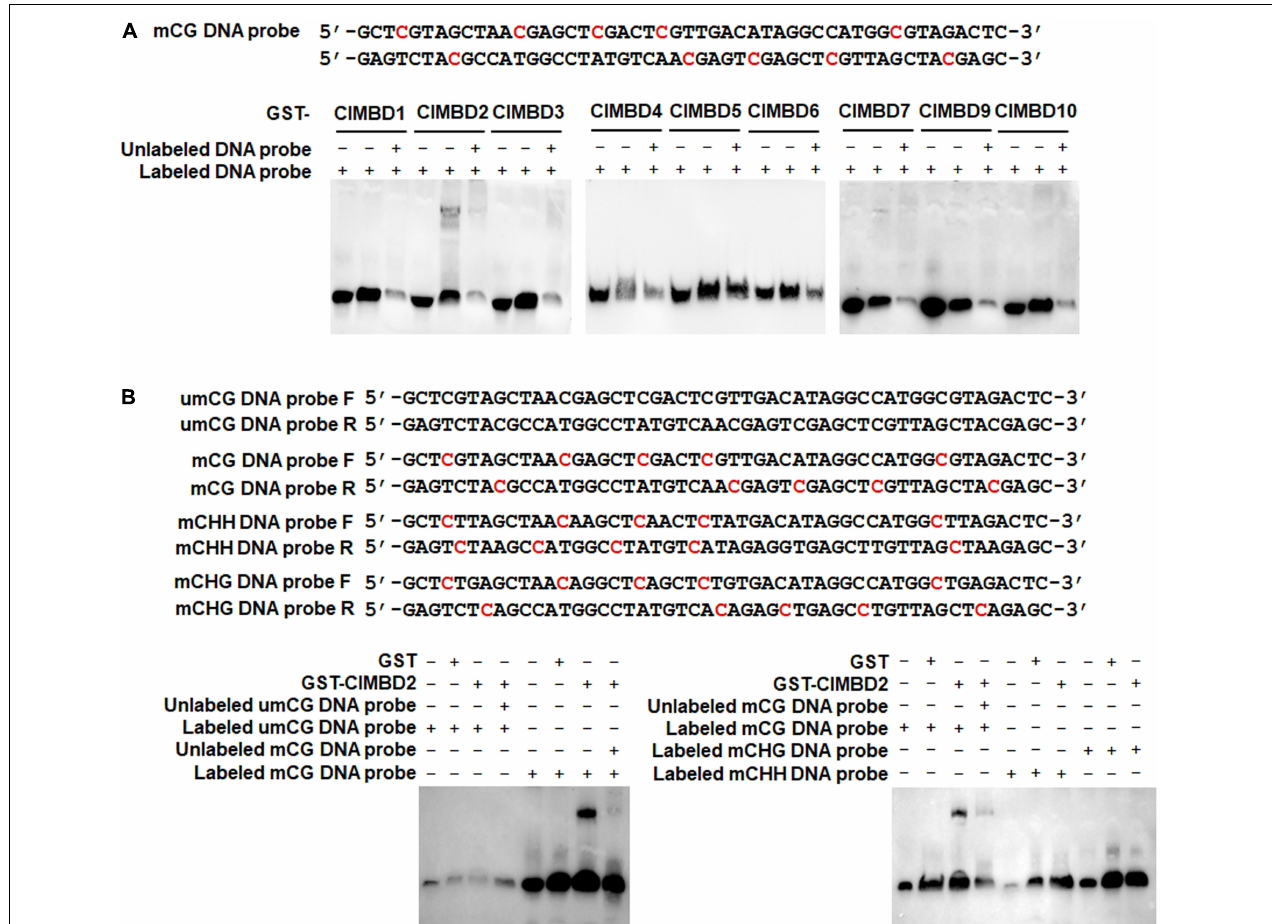
FIGURE 4 | Binding activity of ClMBD2 to methylated CG DNA. (A) Binding of ClMBD proteins to the methylated CG DNA. Biotin-labeled mCG DNA (for binding assays) or biotin-labeled mCG DNA in combination with excessive unlabeled mCG DNA (for competitive assays) were incubated with GST-ClMBD or GST (as a negative control). (B) Binding activity of ClMBD2 to methylated CG DNA, methylated CHG DNA and methylated CHH DNA. Biotin-labeled mCG DNA, biotin-labeled mCHG DNA and biotin-labeled mCHH DNA (for binding assays) or biotin-labeled mCG DNA in combination with excessive unlabeled mCG DNA (for competitive assays) were incubated with GST-ClMBD or GST (as a negative control). The mCG, mCHG, and mCHH DNA sequences are shown and the methylated sites are indicated in red color. Experiments in (A,B) were repeated for three times with similar